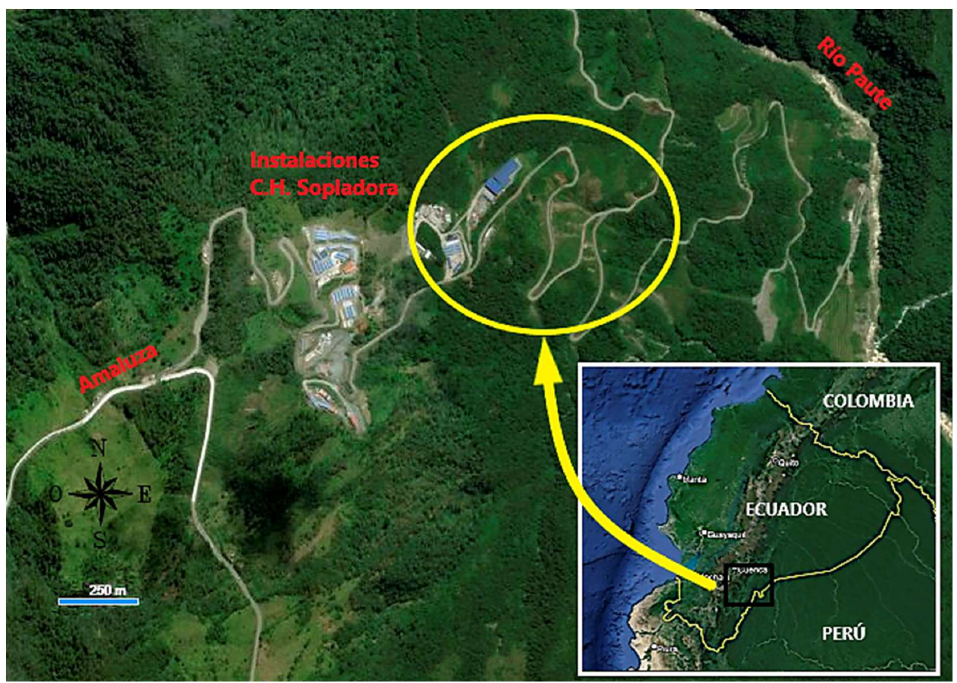
Figure 1. The situation of the investigation area. The yellow circle locates the sliding area (Modified from [22,23]).